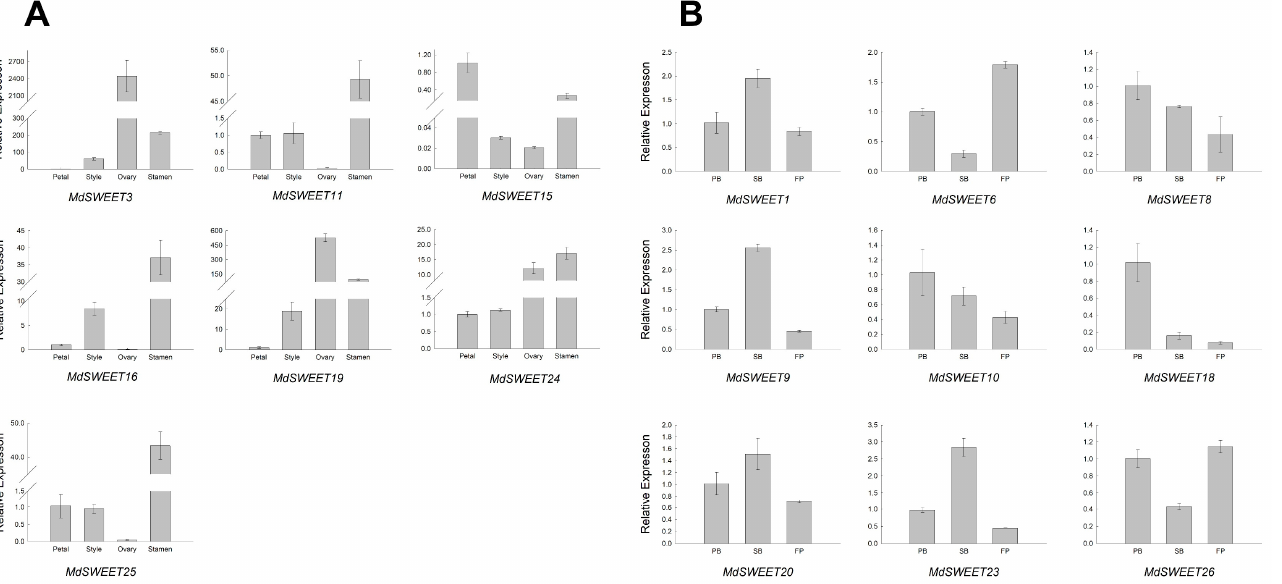
Figure 8. Expression pattern analysis of MdSWEET genes in different tissues of flowers and fruits. ( A ) Expression of MdSWEET genes in four different flower tissues. ( B ) Expression of MdSWEET genes in different fruit tissues. PB indicates petal bundle vascular region; SB indicates sepal bundle vascular region; and FP indicates fleshy parenchyma cell. The significances of the gene expression differences between tissues are indicated, and different lowercase letters indicate the significant difference at 0.05 level by Duncan’s multiple range test.